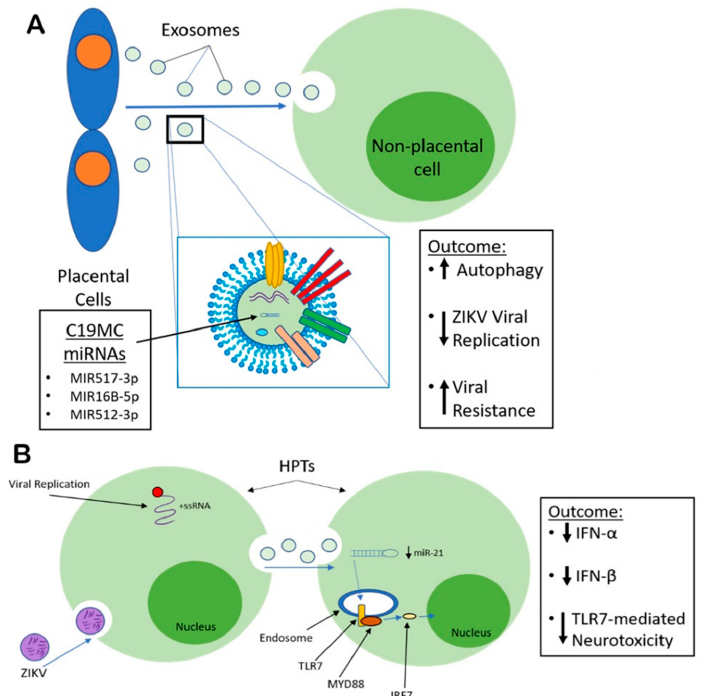
Figure 3. EV-mediated anti-ZIKV e ff ects. ( A ) HPT cell-derived EVs bound with miRNAs with potent anti-viral properties, have been detected. The EVs migrate to non-placental recipient cells conferring anti-ZIKV protection and up-regulating autophagy. ( B ) ZIKV infection of HPT cells results in an anti-ZIKV host-cell response transported via exosome-tra ffi cking, downregulating miR-21 in uninfected HPTs, reducing TLR7-mediated